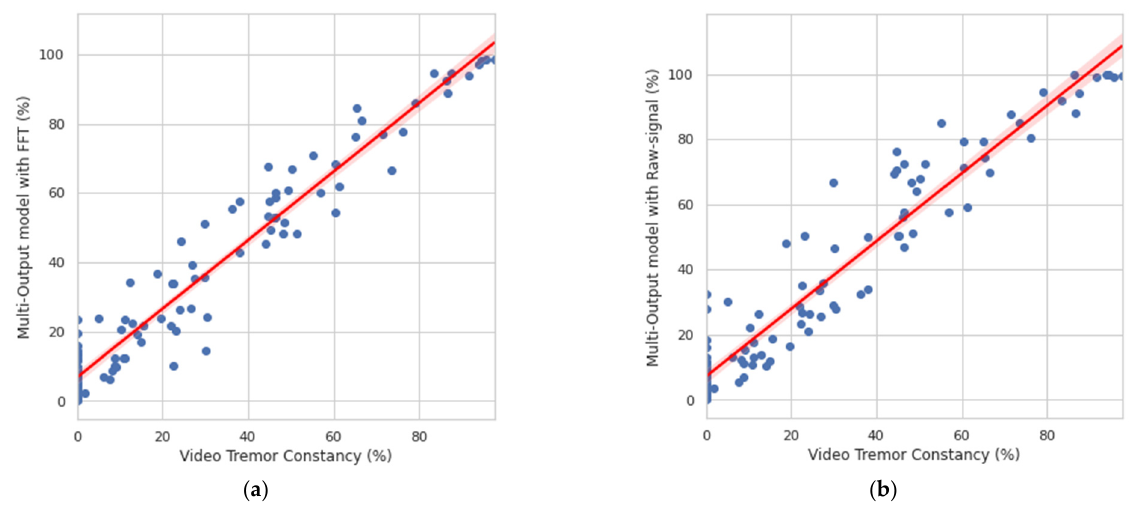
Figure 12. Correlation between the clinical evaluation and the constancy obtained by the system. ( a ) Correlation obtained with the multitask CNN with FFT. ( b ) Correlation obtained with the multitask CNN with raw signals.